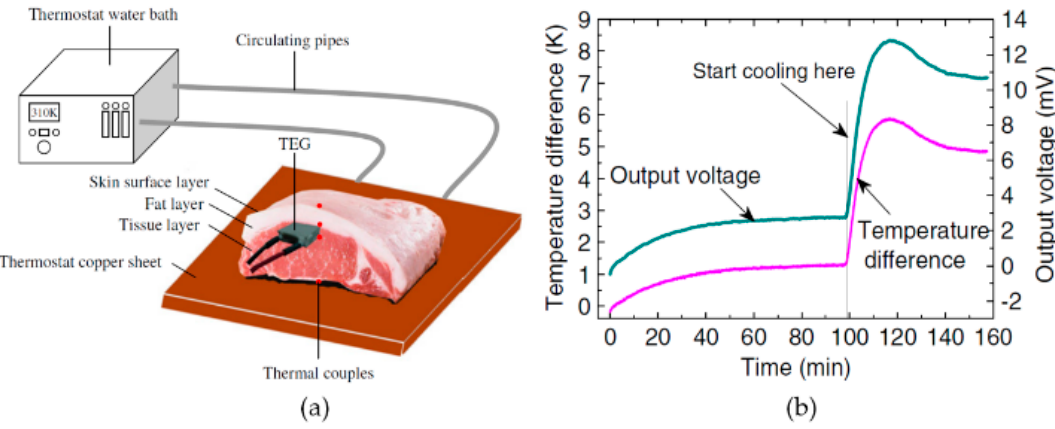
Figure 15. ( a ) In vitro experimental setup; ( b ) output voltage in relation to temperature difference [90].